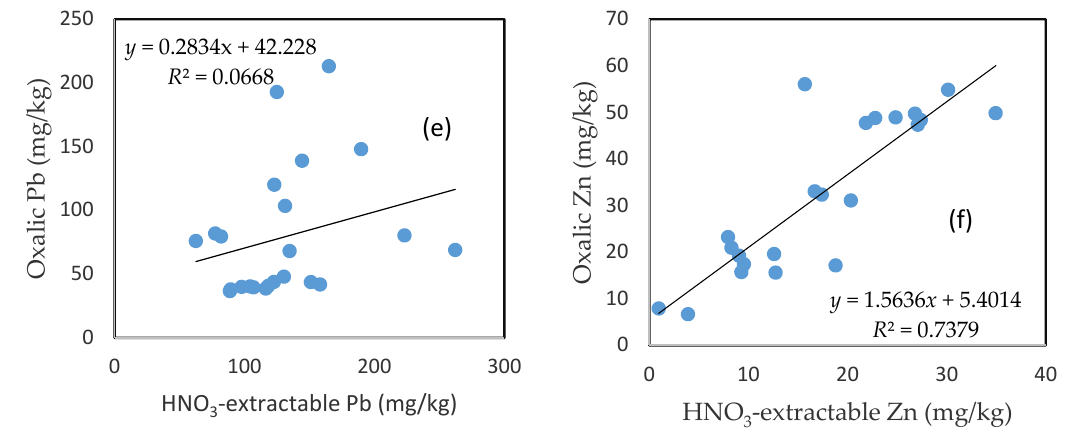
Figure 6. Relationship between the HNO 3 ‐ extractable fraction and the oxalic acid ‐ extractable fraction for ( a ) As, ( b ) Cu, ( c ) Fe, ( d ) Mn, ( e ) Pb, and ( f ) Zn.